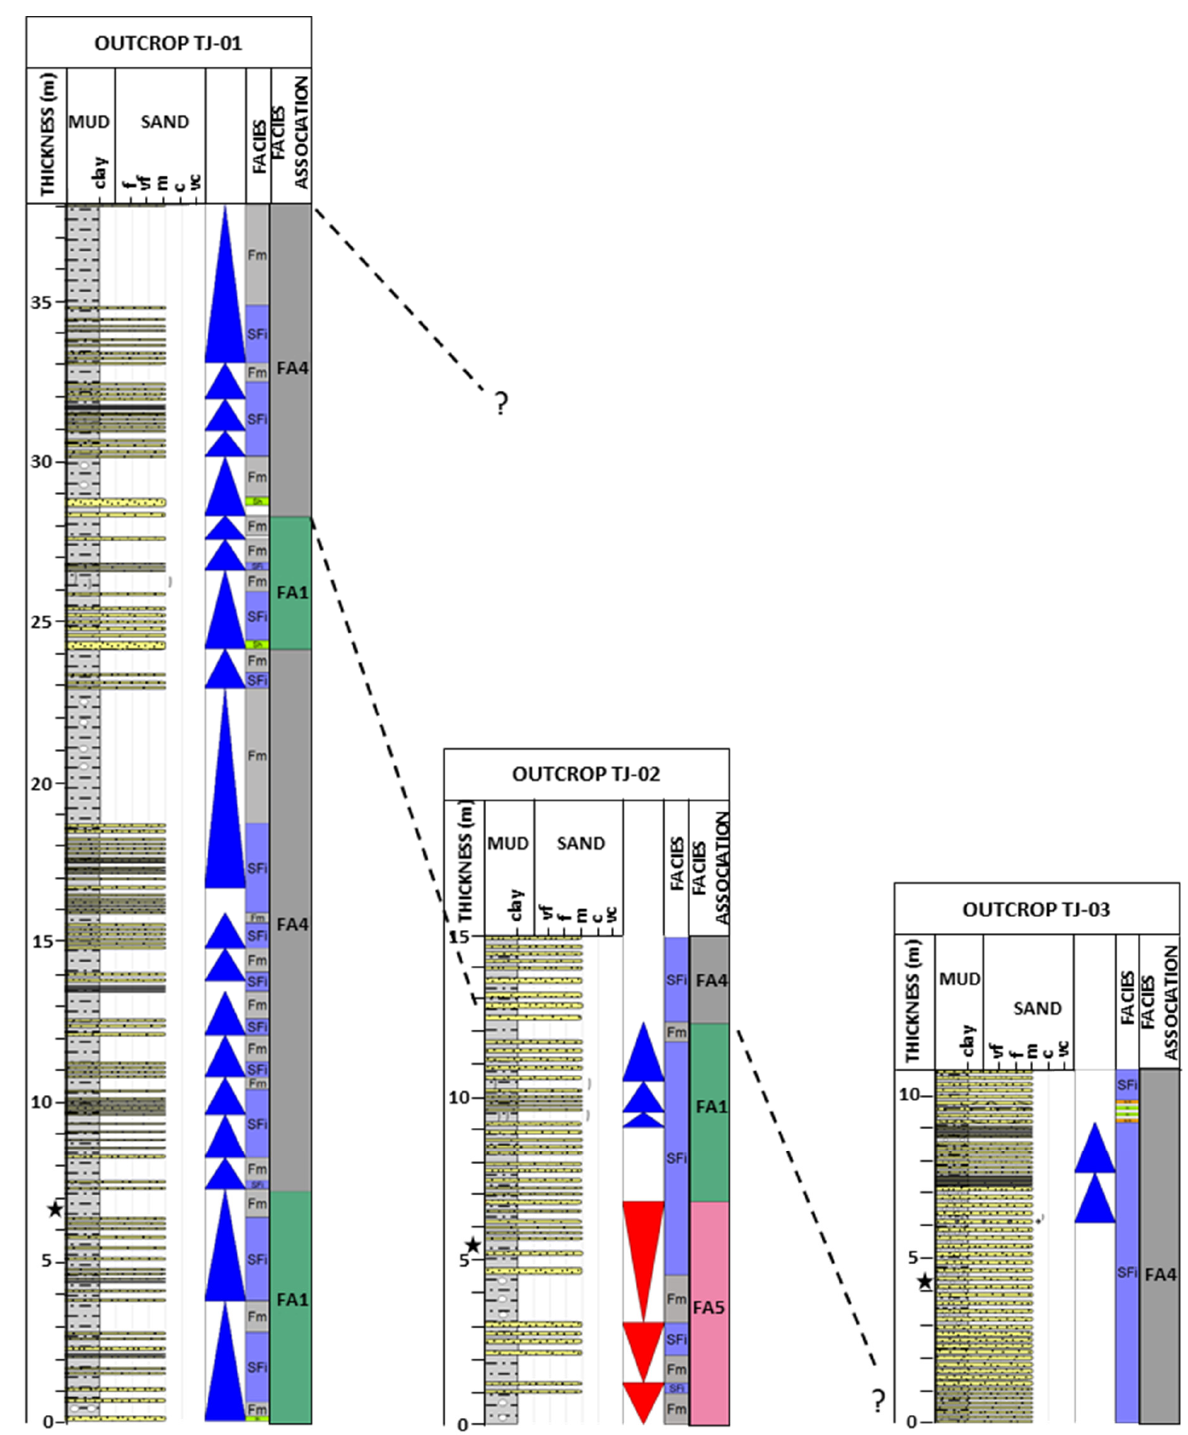
Figure 3. Sedimentary log successions with lithofacies, trace fossils, and facies association information in the studied outcrops of the Unit I Tanjong Formation.